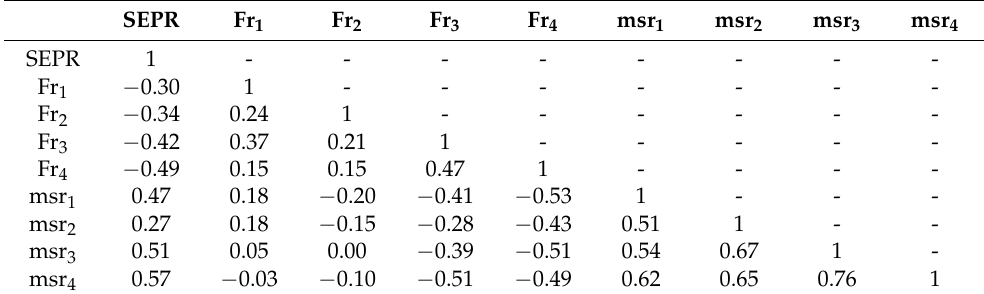
Table 3. Dataset modelling of the impact of the standard financial factors of commercial entrepreneur- ship on social